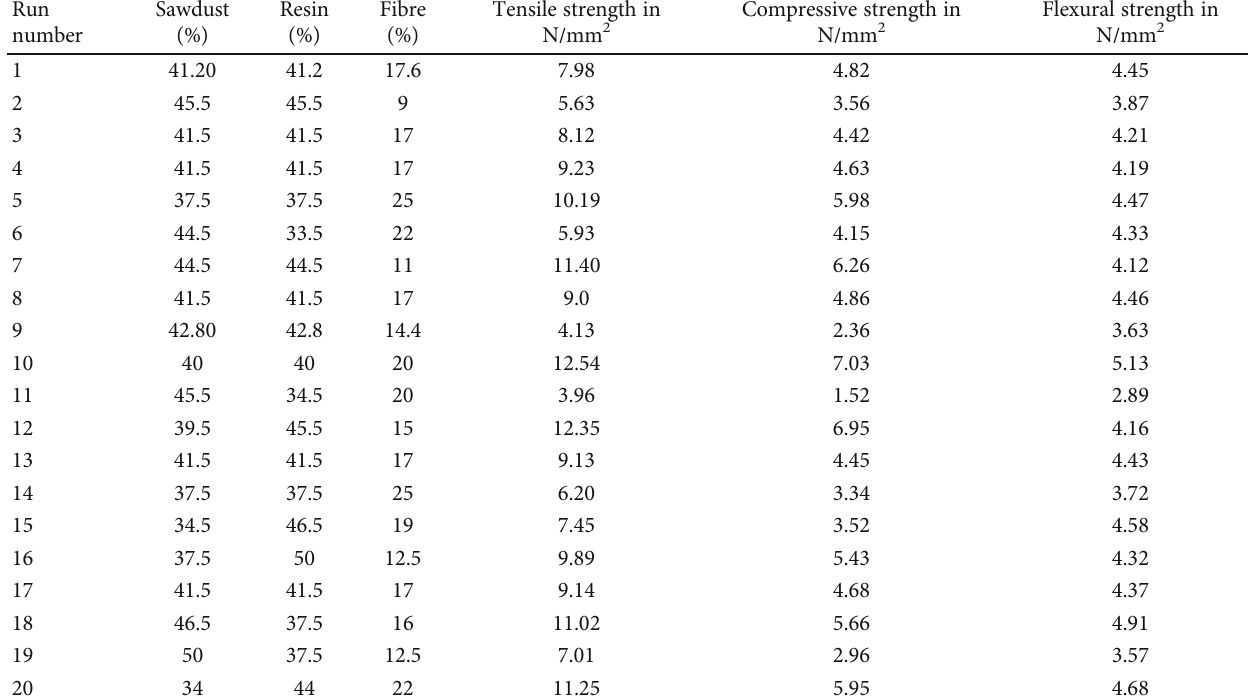
Table 2: Mechanical properties of the composite with di ff erent constituents ’